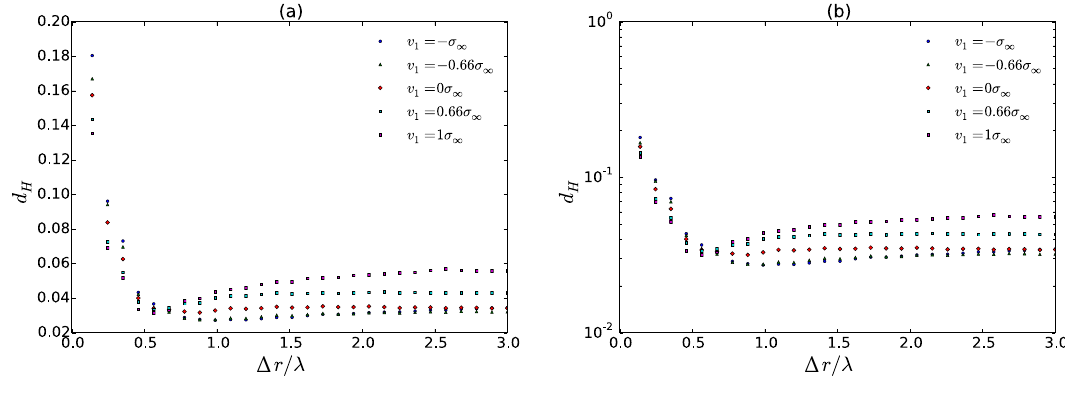
Figure 24. ( a ) Hellinger distance d H ( ∆ r ) for different v 1 and variable step width ∆ r . Apparently, the Markov property is a good approximation only around ∆ r = λ . For larger ∆ r , the Hellinger distance slightly increases and approaches a small constant value. However, for smaller ∆ r , the Hellinger distance exhibits a more pronounced increase. Therefore, the Markov property is clearly violated. These effects become even more pronounced for v 1 = − 0.33 σ ∞ , − 0.66 σ ∞ ,, − σ ∞ . ( b ) Semi-logarithmic plot of the Hellinger distance d H ( ∆ r ) . For r < 0.8 λ , the Hellinger distance seems to increase nearly